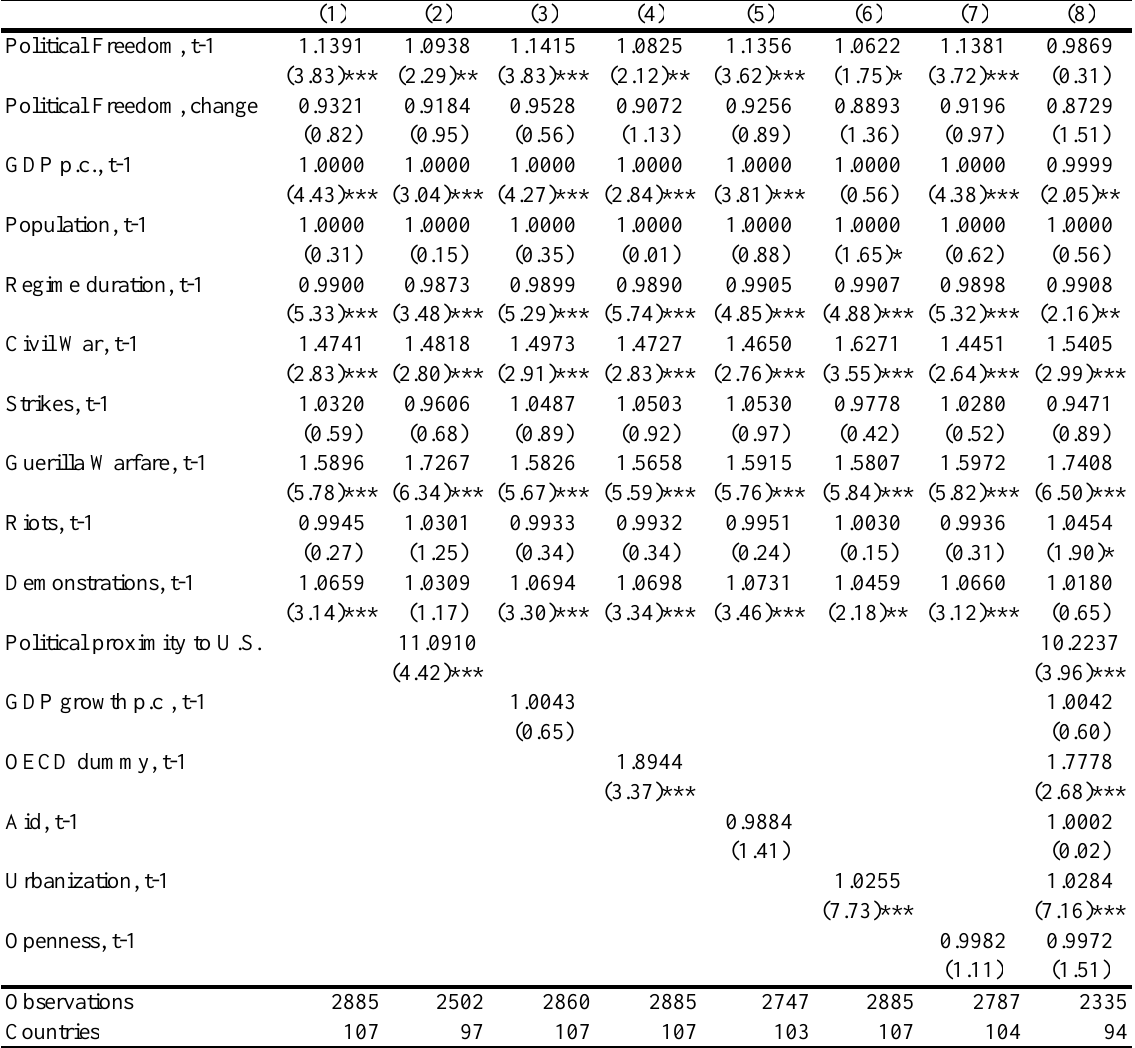
Table 5: Determinants of International Terror Events (Number of Fatalities), Developing and Developed Countries, 1972-2003, Fixed-Effects Negative Binomial Panel